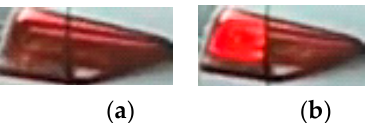
Figure 13. Vehicle taillight area image. ( a ) Unlit left taillight image; ( b ) Illuminated left taillight image.